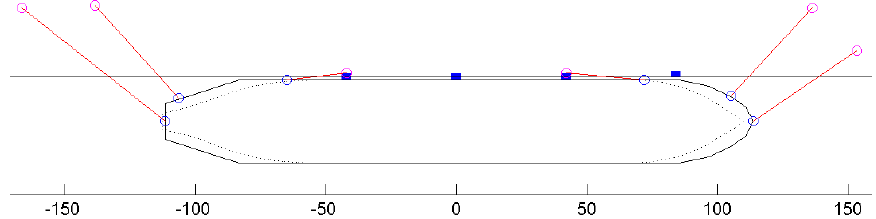
Figure 8. Mooring layout for the Panamax bulk carrier moored at Berth 5. All mooring legs are treated as double or triple mooring lines as indicated.